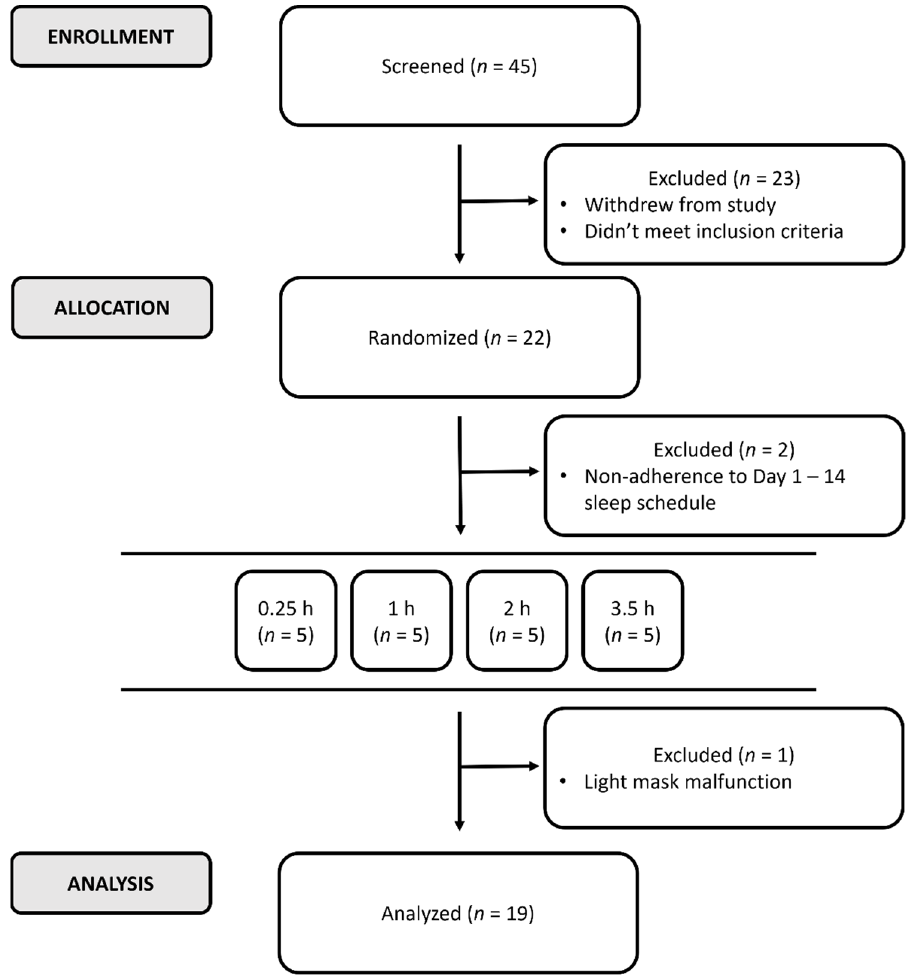
Figure 1. CONSORT diagram [18] of participant recruitment and allocation. Of the individuals evaluated, 51% did not meet inclusion criteria or declined to take part in the experiment. Of the participants empaneled, 9.1% were excluded due to non-adherence to target at-home sleep/wake times. Twenty-two participants took part in the in-lab component, quasi-randomized into five participants per illuminance level (see Protocol). The data of one participant (5%) was excluded in the 1 h condition due to failure of the experimental device.